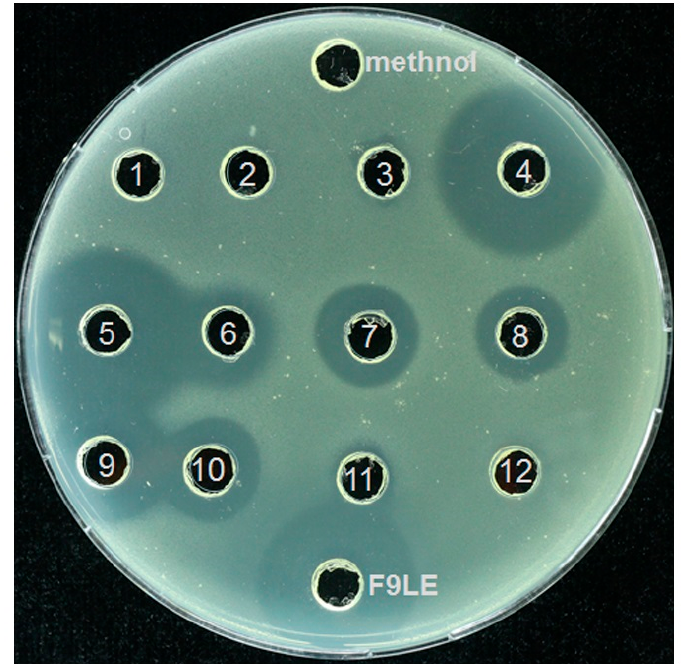
Figure 6. Purification of F9LE by high-performance liquid chromatography. The F9LE obtained by the combination of hydrochloric acid precipitation and acetone extraction was further separated by preparative high-performance liquid chromatography. A total of 12 fractions were collected at regular intervals for elution. The fractions acquired by HPLC were subjected to agar diffusion assay to determine bacteriostatic activity.